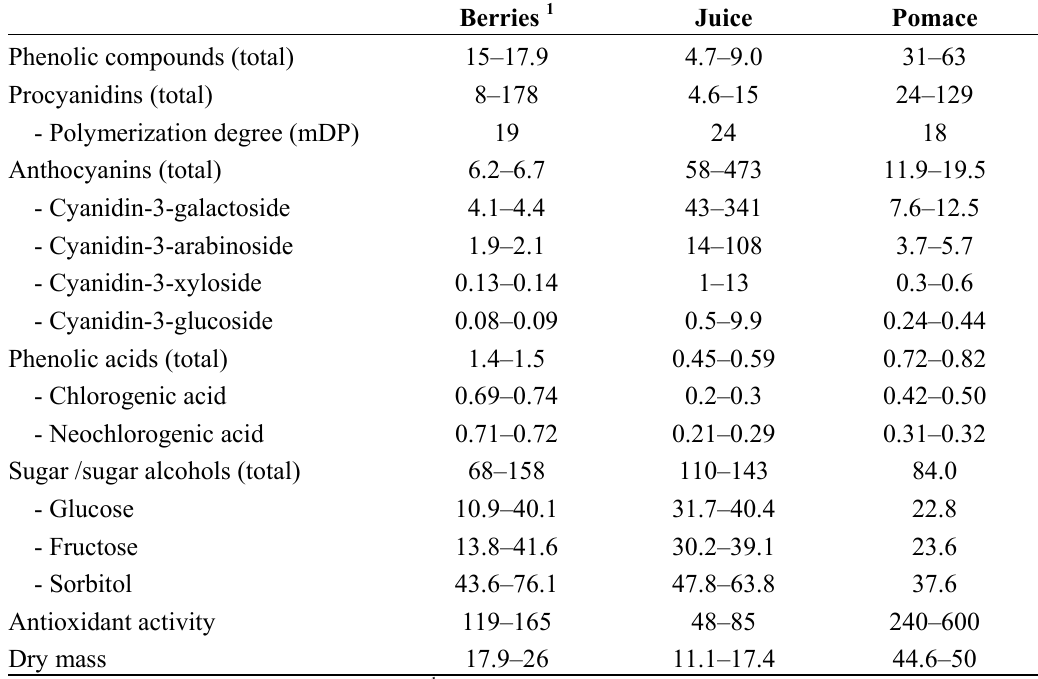
Table 1. Phenolic constituents, sugar, sugar alcohols content (g/kg pomace, g/L for juice), dry mass (%, w/w), and antioxidant activity (mmol/kg chokeberries, commercial juice and pomace (one to three lots; mean